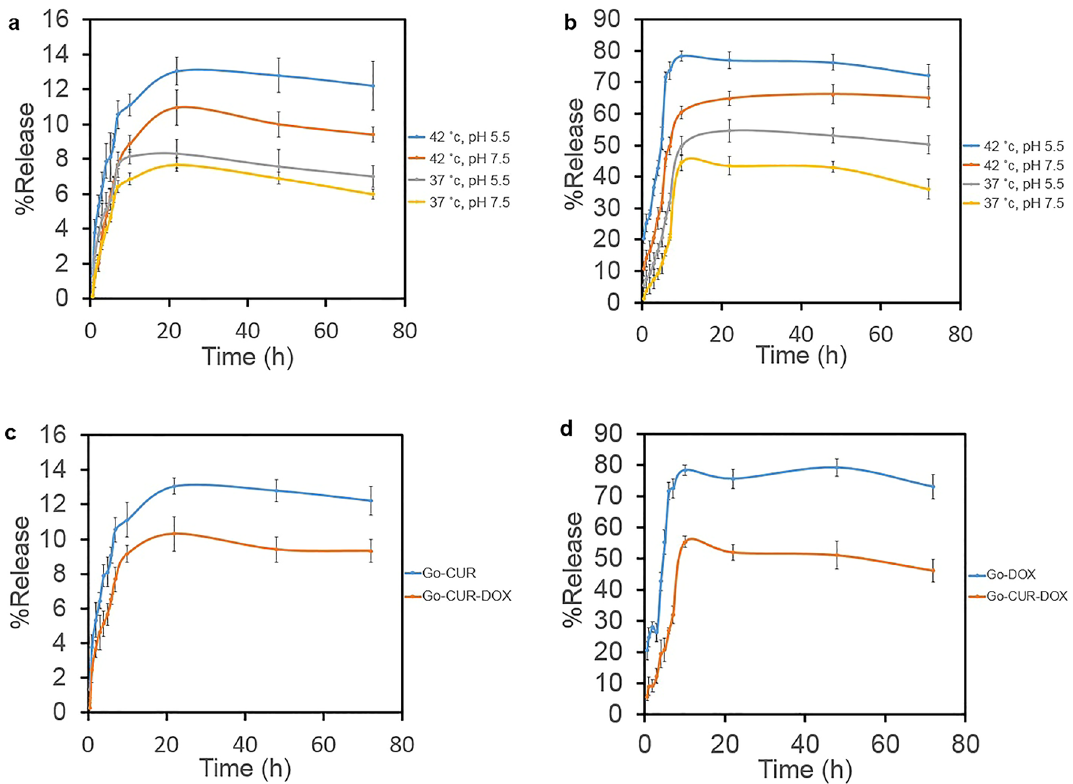
Figure 2. The drug release profile of ( a ) CUR, ( b ) DOX and ( c ) CUR from GO-CUR and GO-CUR-DOX nanocarriers at 37 °C and pH 7.5 ( d ) DOX from GO-DOX and GO-CUR-DOX nanocarriers at 37 °C and pH